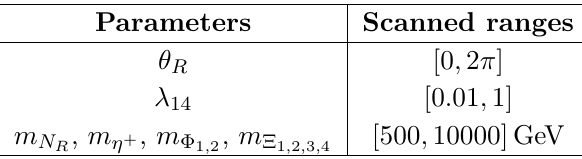
Table 3 . Scanned parameter